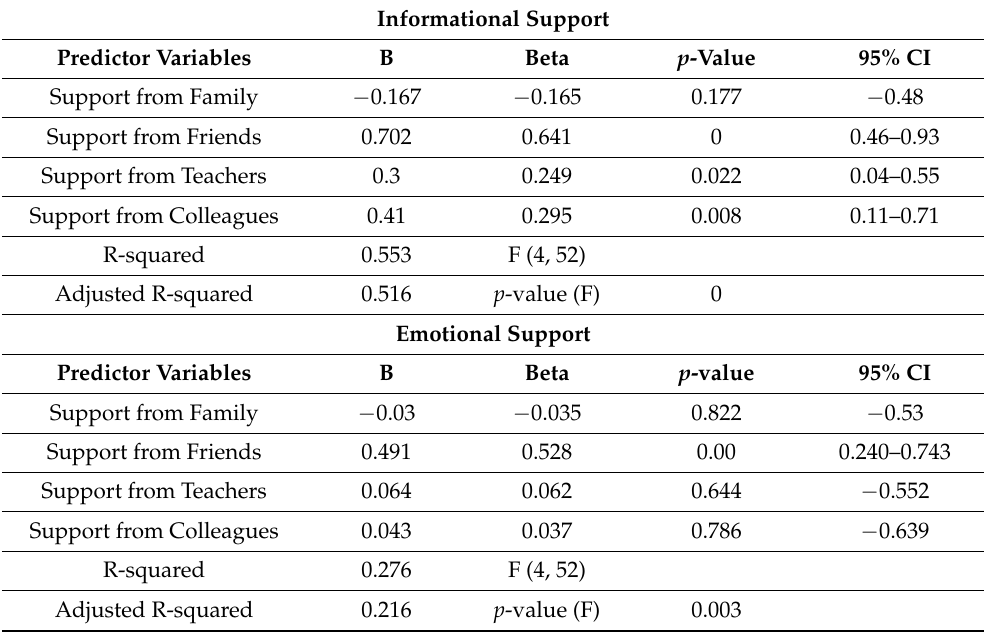
Table 4. Results of multiple linear regression analysis to determine the relationship of support from family, friends, teachers, and colleagues with informational support and emotional support.